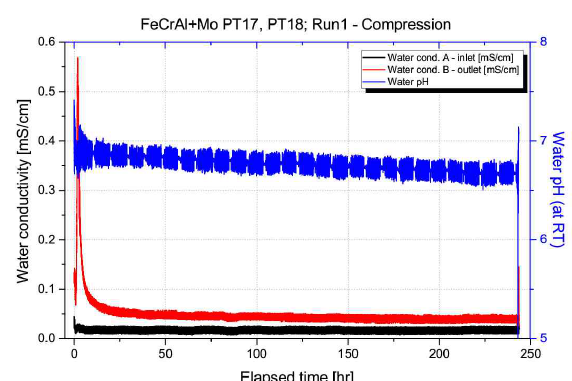
Figure 8. FeCrAl+Mo Run 1 - Water inlet and outlet conductivity and pH.